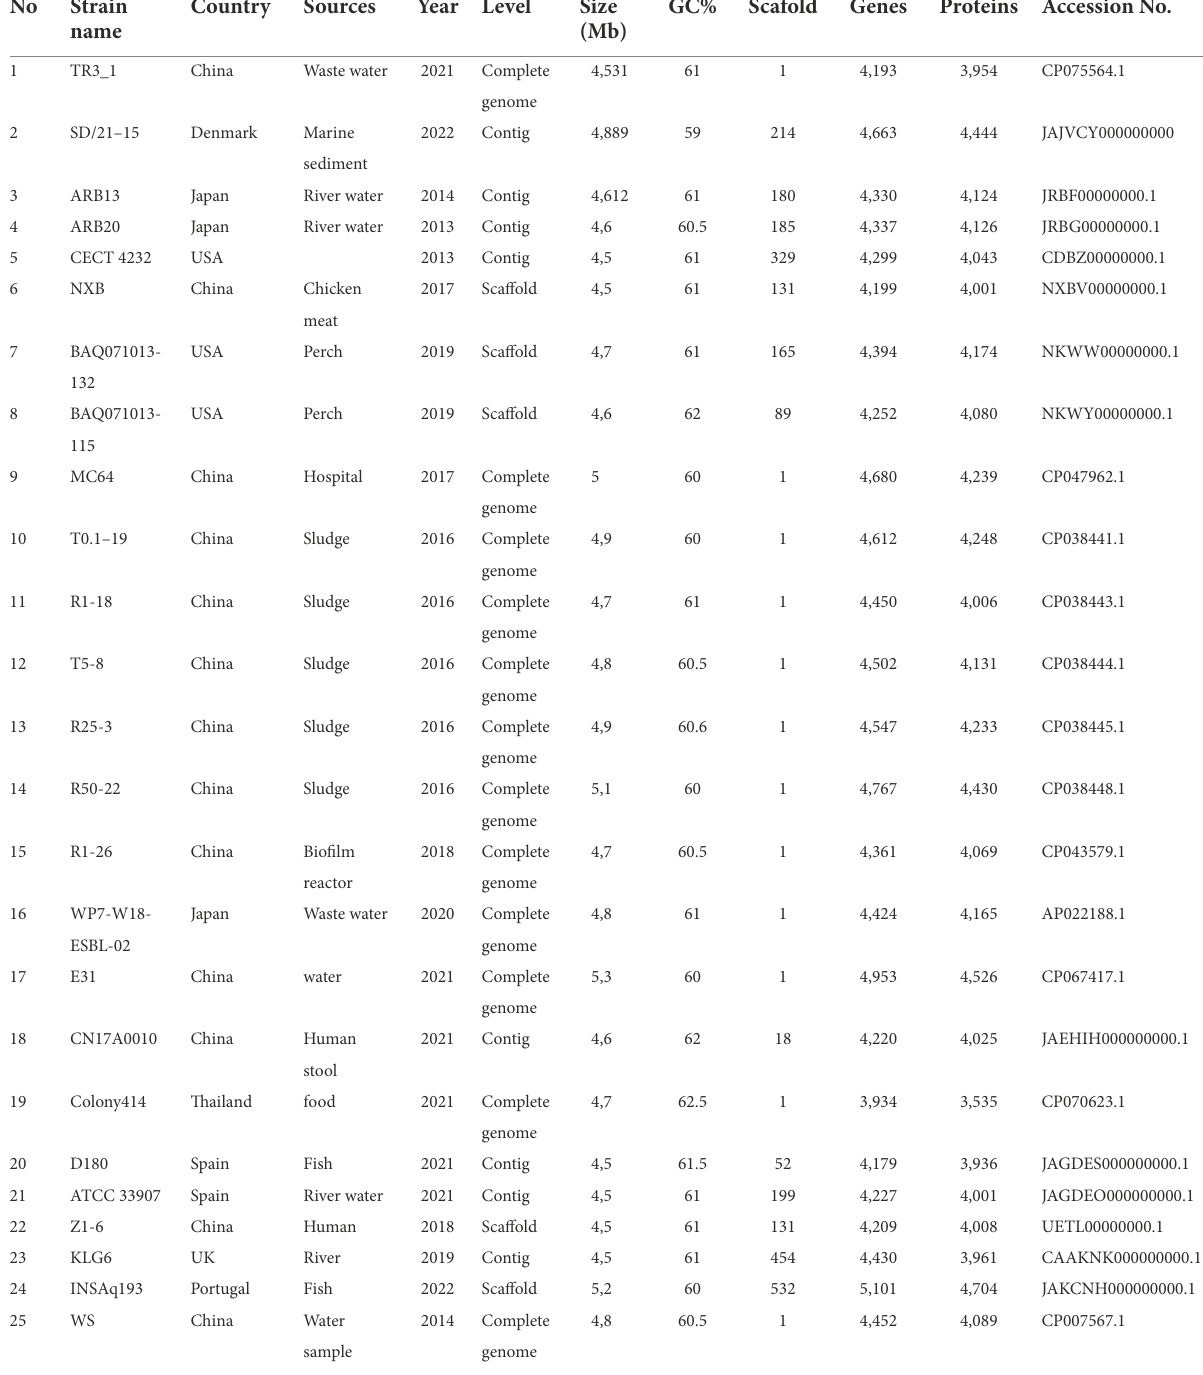
TABLE 1 Genome data of Aeromonas media strains used in the